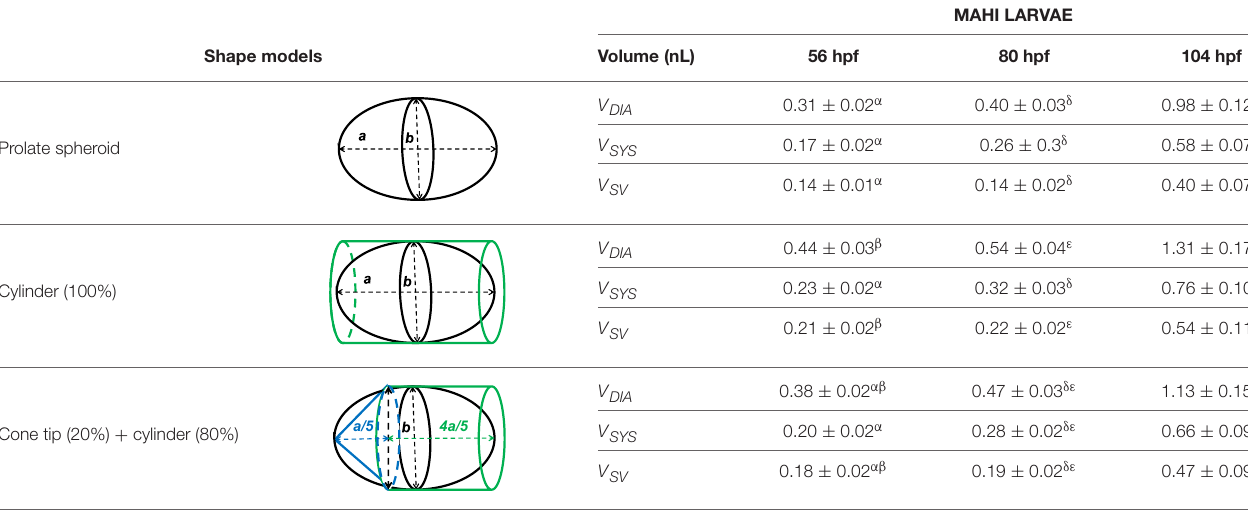
TABLE 3 | Evaluation of diastolic, systolic and stroke volumes using three shape models through three post-embryonic stages (56, 80, and 104 hpf) of